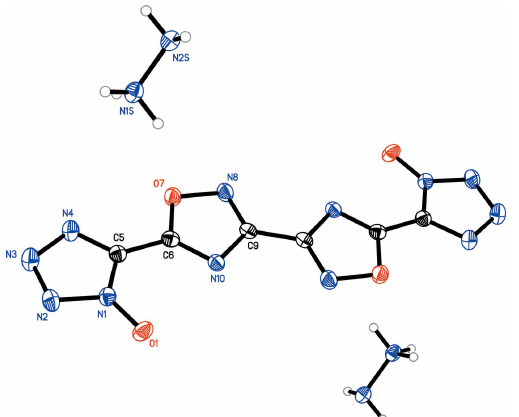
Figure 4 Molecular structure of 4 , showing the atom-labeling scheme. Displace- ment ellipsoids are drawn at the 50% probability level.